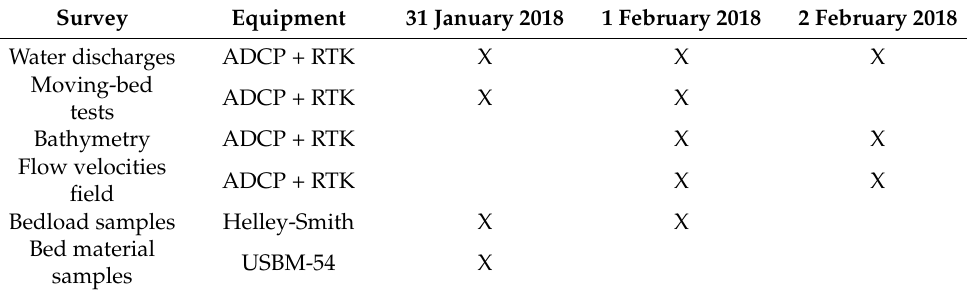
Figure 2. ( a ) Cross-section P1 and verticals of static measurements; ( b ) depth points measured during the ADCP bathymetric survey. Flow occurs from right to left.